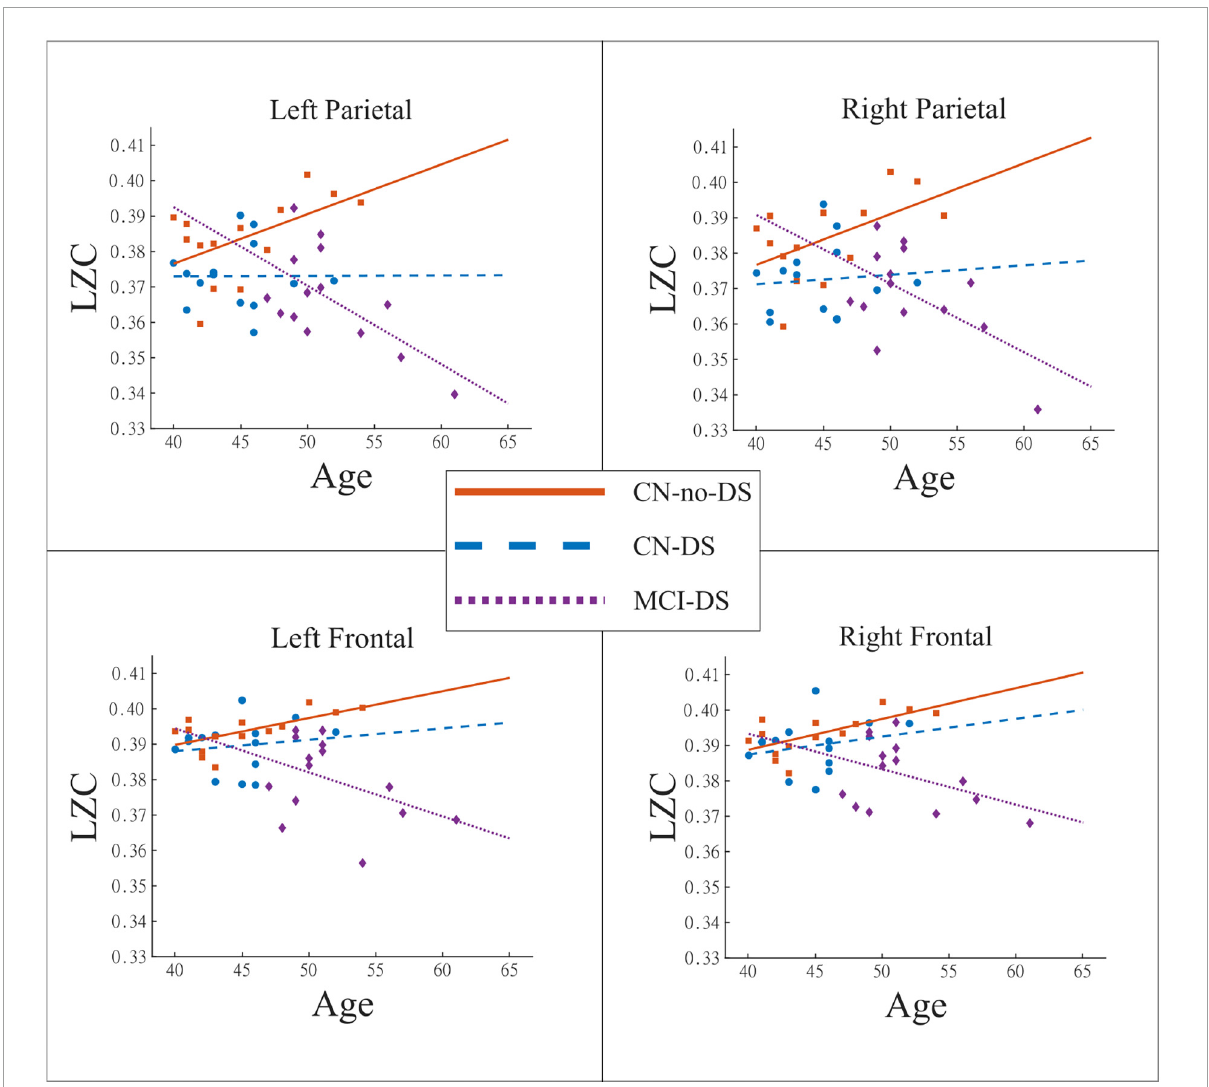
FIGURE2 Relationship between Age and LZC. These plots use regression lines to show the evolution of the brain signals complexity with the age of the participant. The CN-no-DS group exhibited the expected pattern of significant increase of LZC as a function of age, while that pattern was “broken” in CN-DS and especially in MCI-DS. CN, control; DS, Down syndrome; LZC, Lempel-Ziv complexity; MCI, mild cognitive